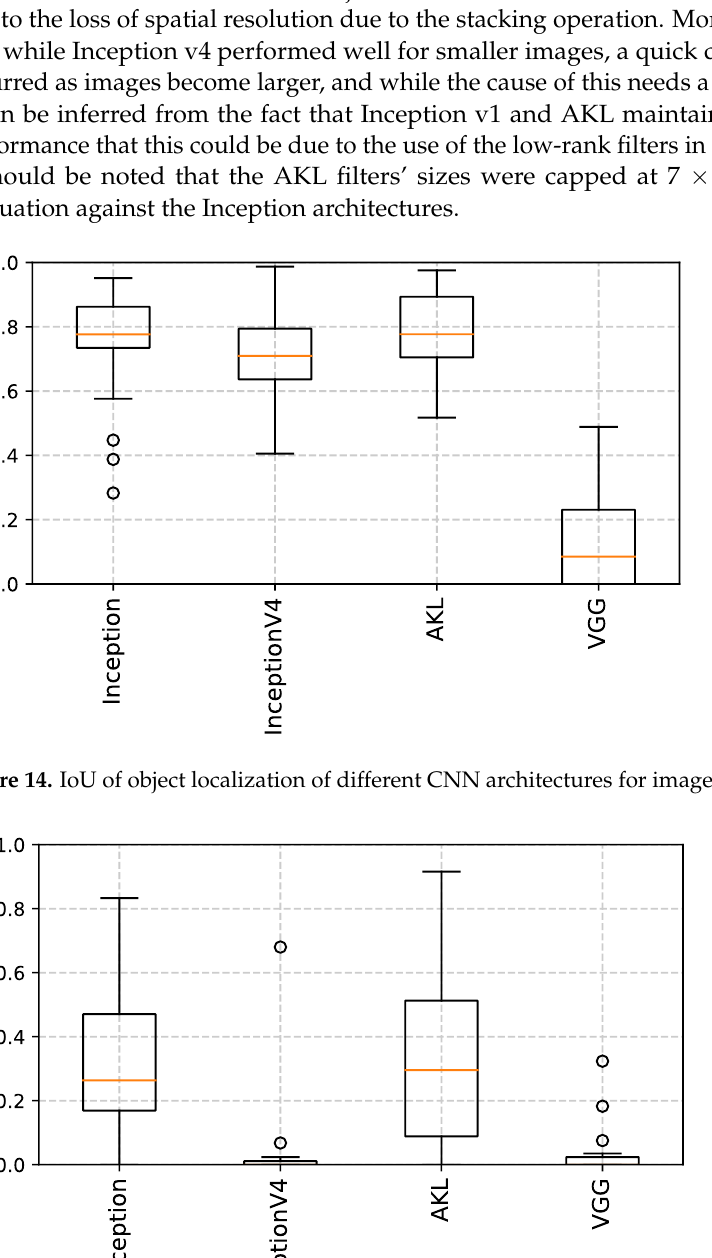
512. There 512. A 512. A × ˆ ˆ